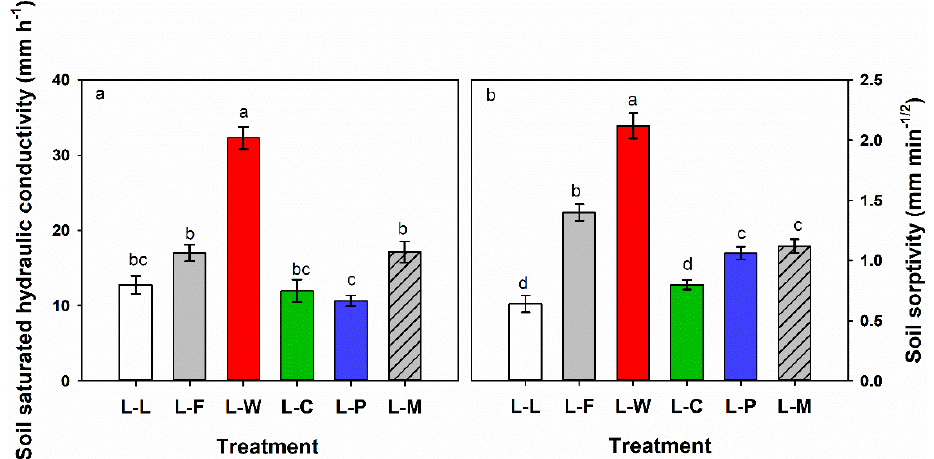
Figure 2. Soil saturated hydraulic conductivity ( a ) and soil sorptivity ( b ) under lucerne-to-crop conversion in October 2015. For a given dependent variable, bars with different letters indicate significant difference ( p ≤ 0.05). Error bars indicate standard deviations of the means ( n = 3). Treatment abbreviations are defined in Table 1.